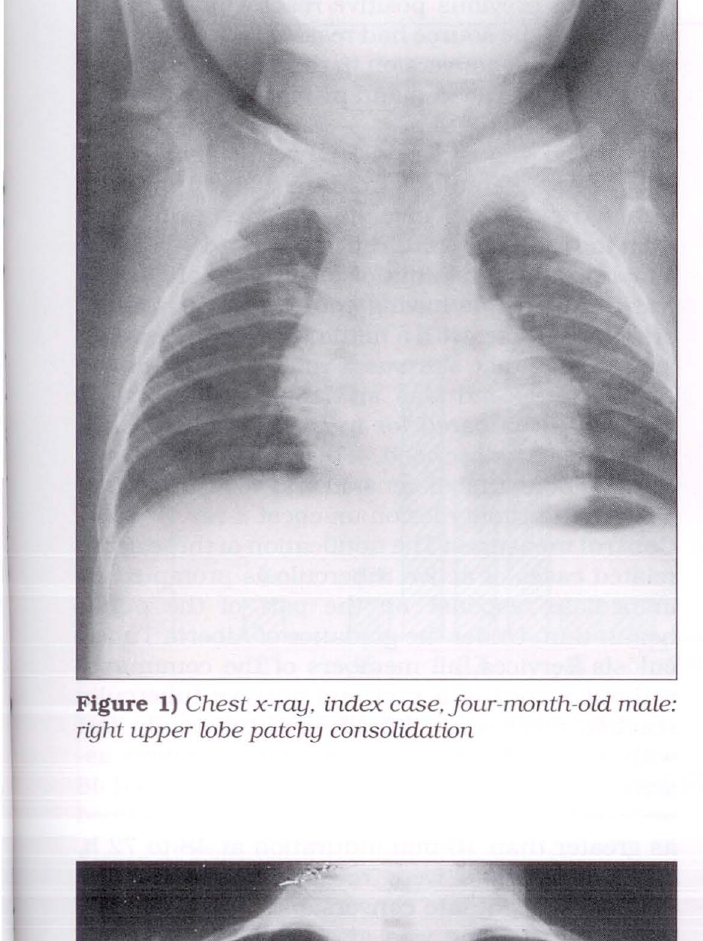
Figure 1) Chest x-ray, index case, jour-month-old male: right upper lobe patchy consolidation